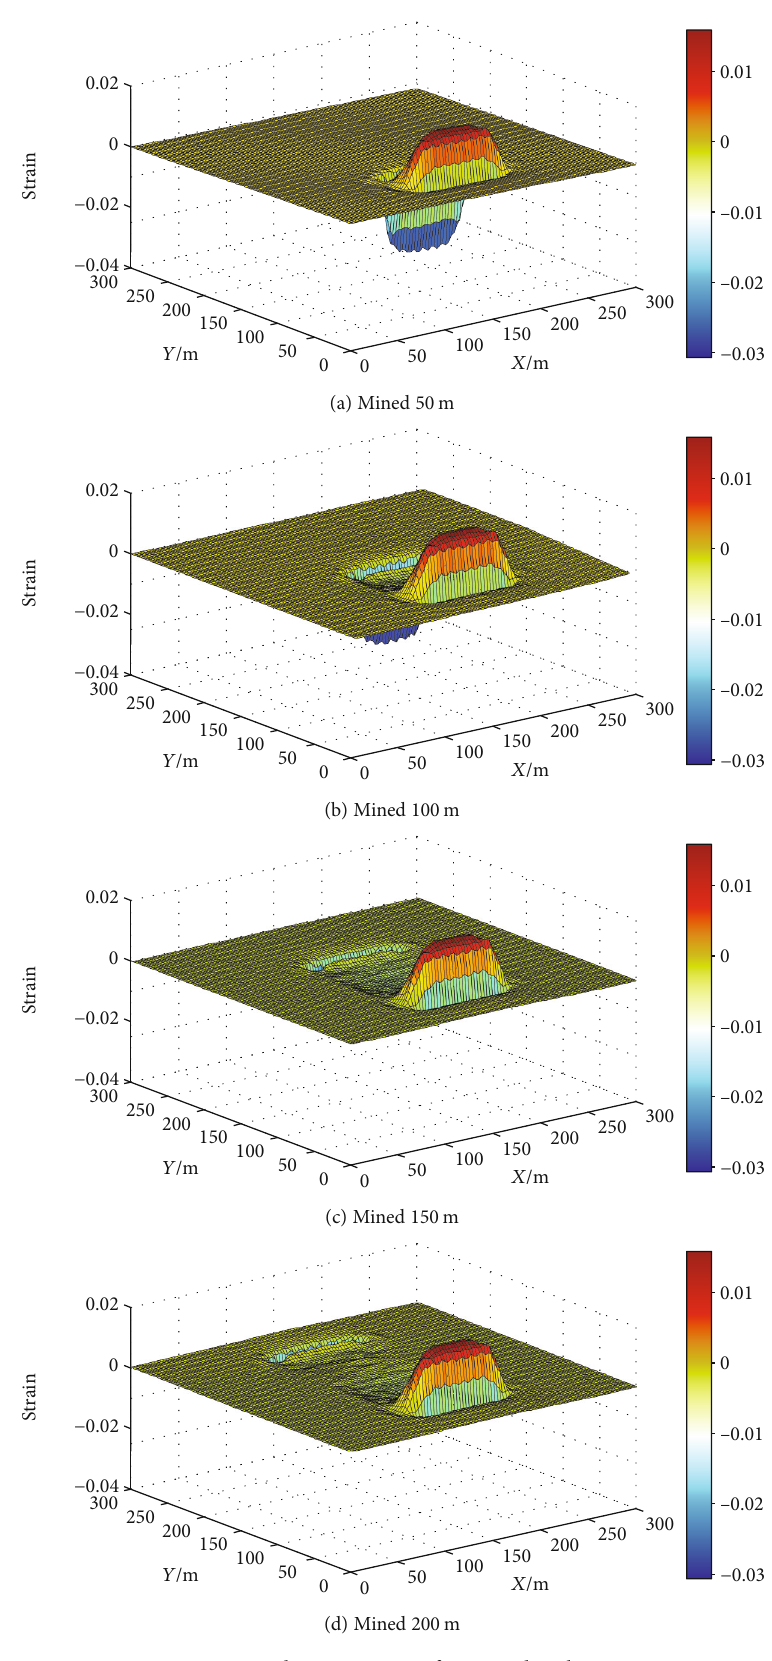
Figure 4: Y - direction strain of protected coal